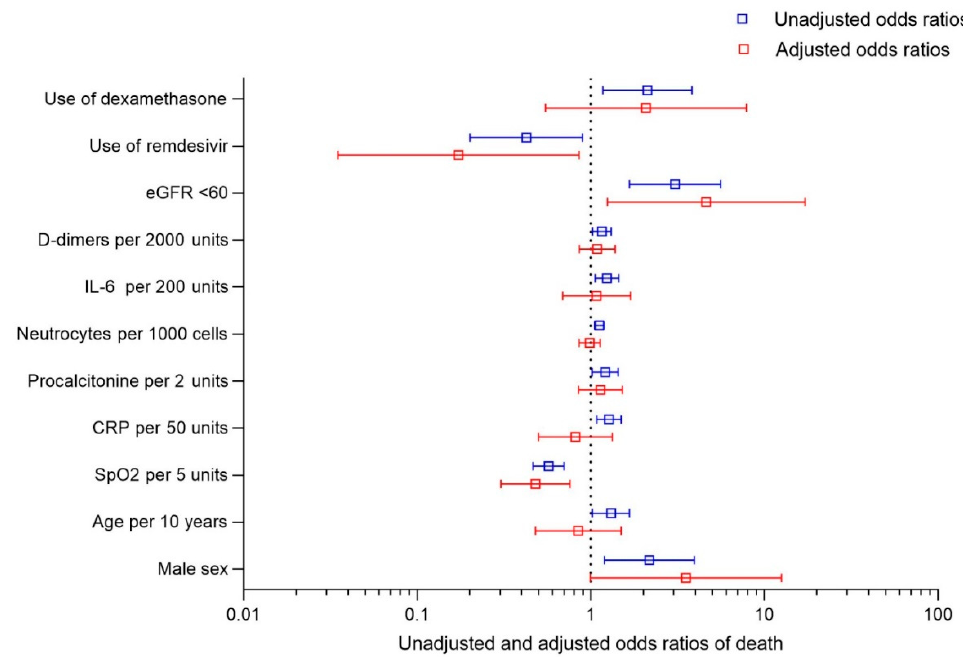
Figure 1. Unadjusted and adjusted odds ratio of 28-day mortality in COVID-19 patients with active malignancy.